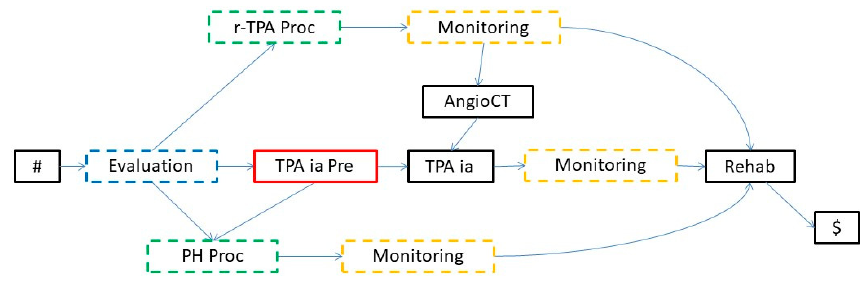
Figure 13. Process model interactively abstracted at level 3 with a different strategy.